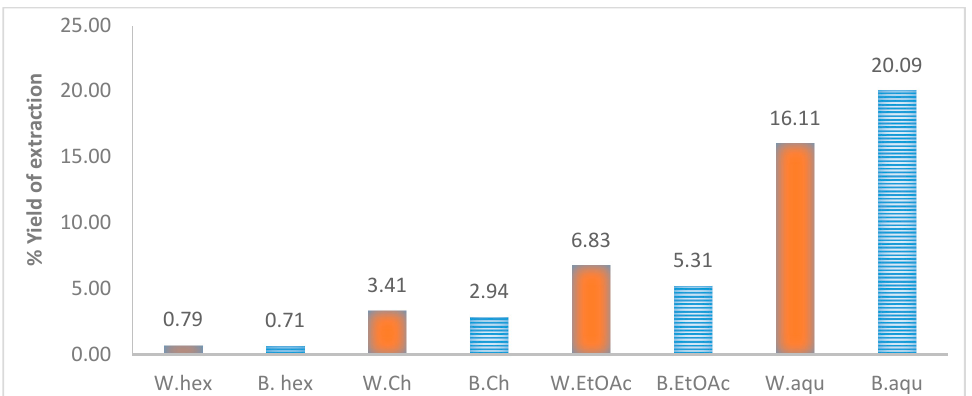
Figure 2. Percentage yield (% w / w ) resulting from sequential extraction and liquid/liquid partition of the stem wood and stem bark of Terminalia brownii . W, stem wood; B, stem bark; hex, hexane extract; Ch, choloroform extract; EtOAc, ethyl acetate extract; aqu, aqueous extract.